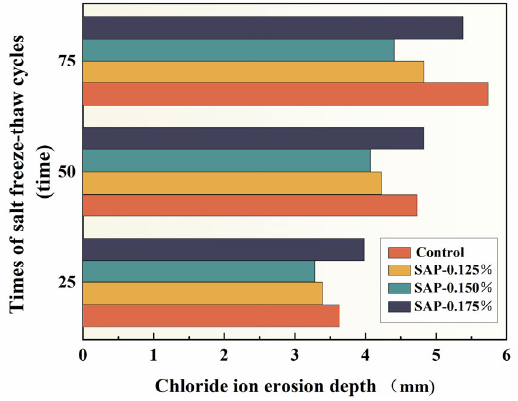
Figure 7. Variation of chloride ion erosion depth with salt freeze–thaw cycles times.